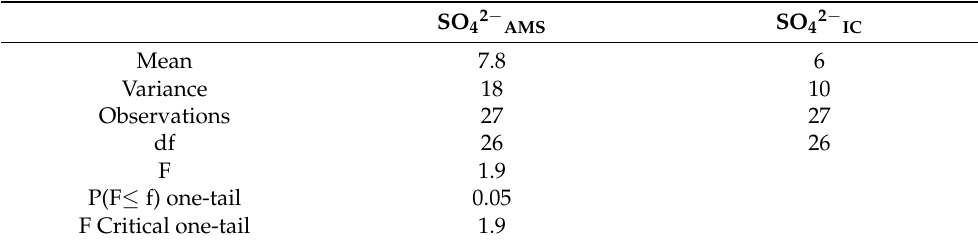
Table 3. Result of F- test between SO 42 − (AMS) and SO 42 − (IC). SO 42 − AMS SO 42 −